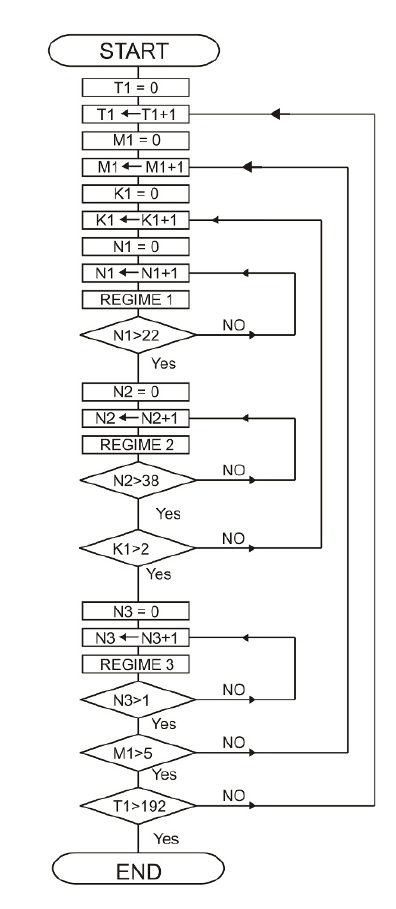
Figure 3. Flow chart of